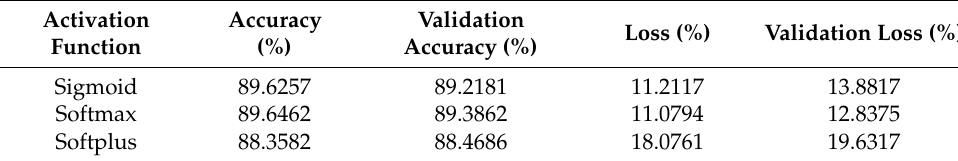
Table 2. Comparison chart for various activation layers of Adam